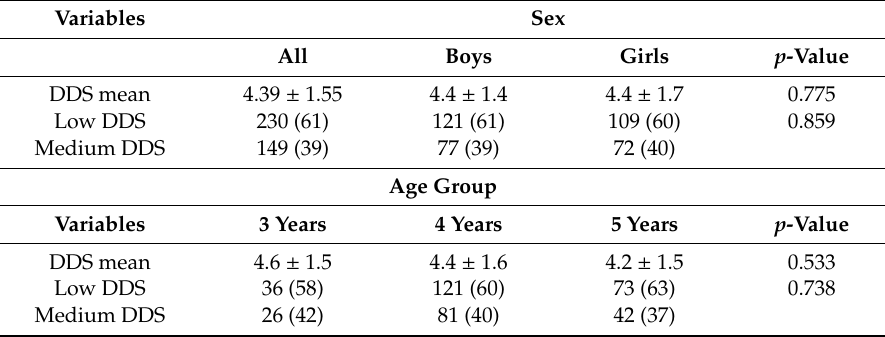
Table 3. Dietary diversity of children by sex and age group.